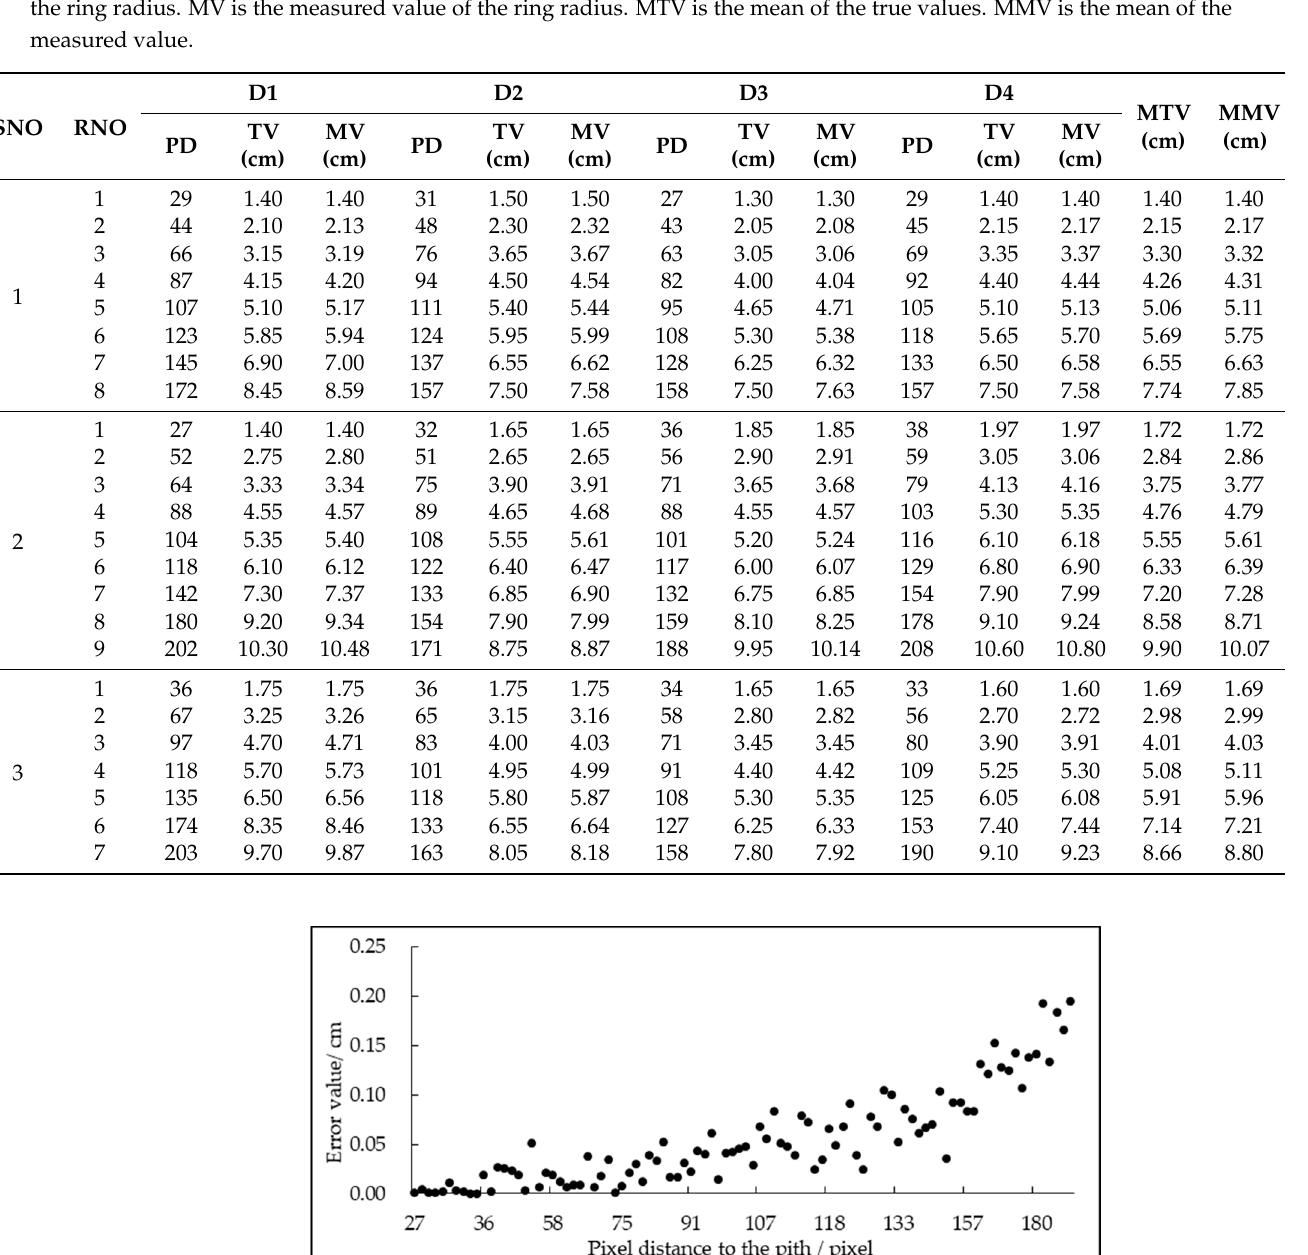
Figure 4. The distribution of error values corresponding to the pixel distance from the tree ring to the pith. the